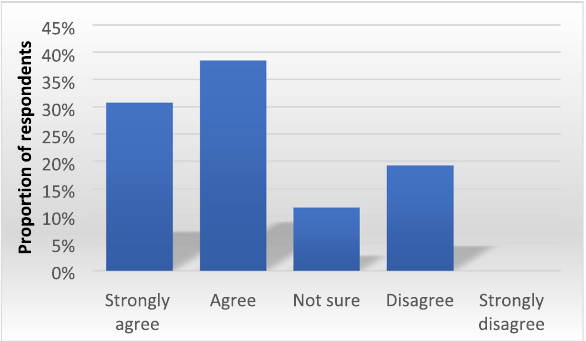
Fig. 3 Different mandates, programs, and measures are obstacles to developing coherent disaster risk reduction and climate change adaptation policies. Source Online survey of respondents in the Southern African Development Community study ( N = 26)